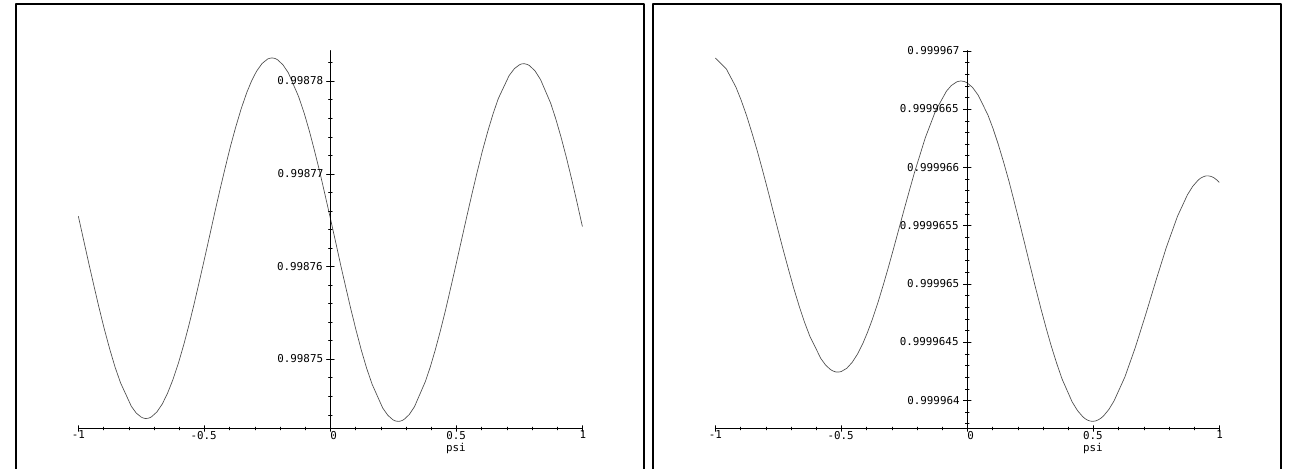
Fig. 9: First full part distribution ( m (cid:0) 2, observed = circle, asymptotic = line)